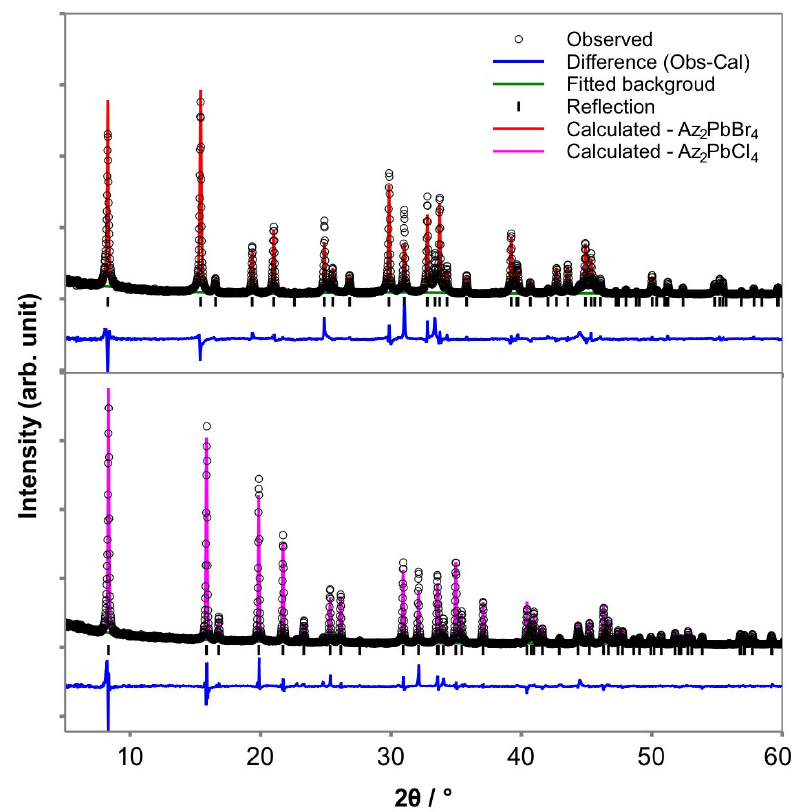
Figure 2. Rietveld refinement of PXRD data in I 4/ mmm space group of Az 2 PbX 4 , X = Br (top) and Cl (bottom) obtained from mechanosynthesis with observed data (open circles), calculated data (red line for Br and magenta line for Cl), background (green lines), reflection positions (black bars) and difference plots (blue lines).